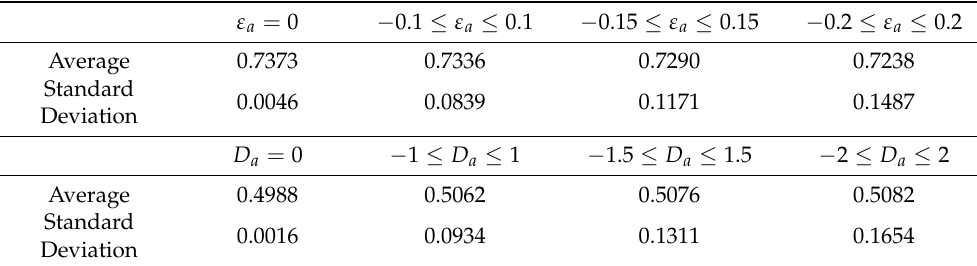
Table 1. Time-domain indicators under different fault severity degrees.